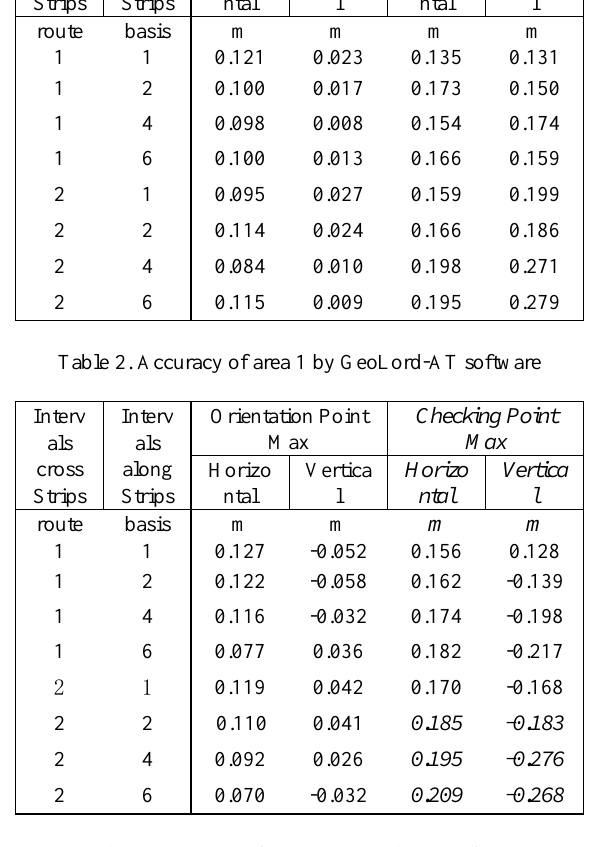
Table 3. Accuracy of area 1 by PixelGrid software